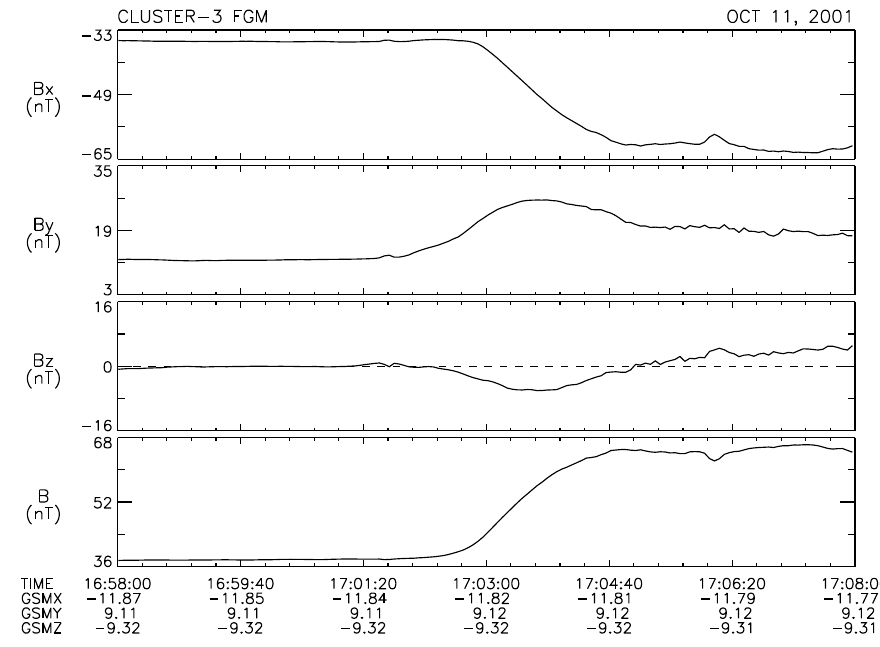
Fig. 11. Tail lobe SI event on 11 October 2001. Panels show magnetic field components in the GSM coordinate system and the magnetic field magnitude. The GSM-position of Cluster was ( − 11.81, 9.12, − 9.33) R E .